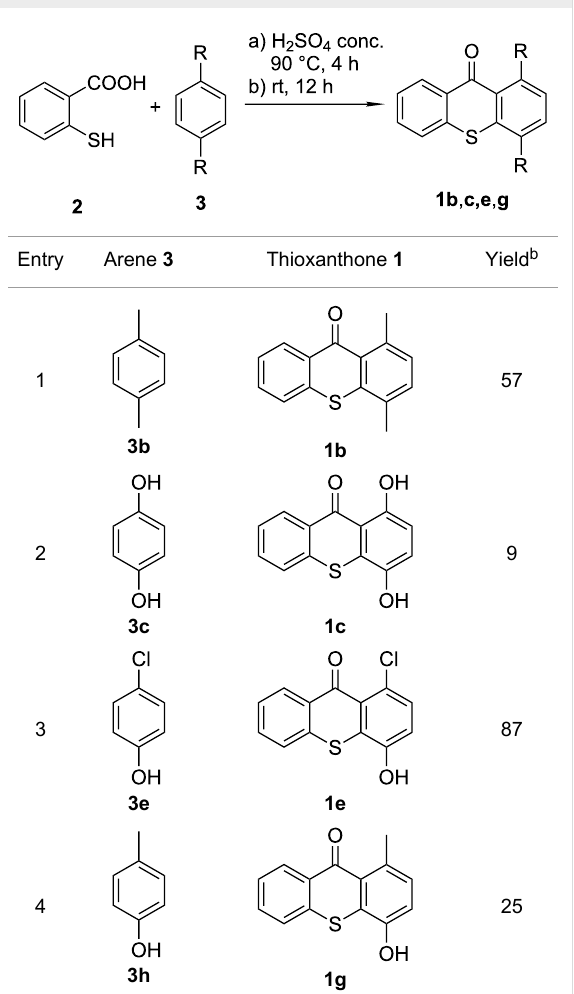
Table 1: Synthesis of substituted thioxanthones from thiosalicylic acid.